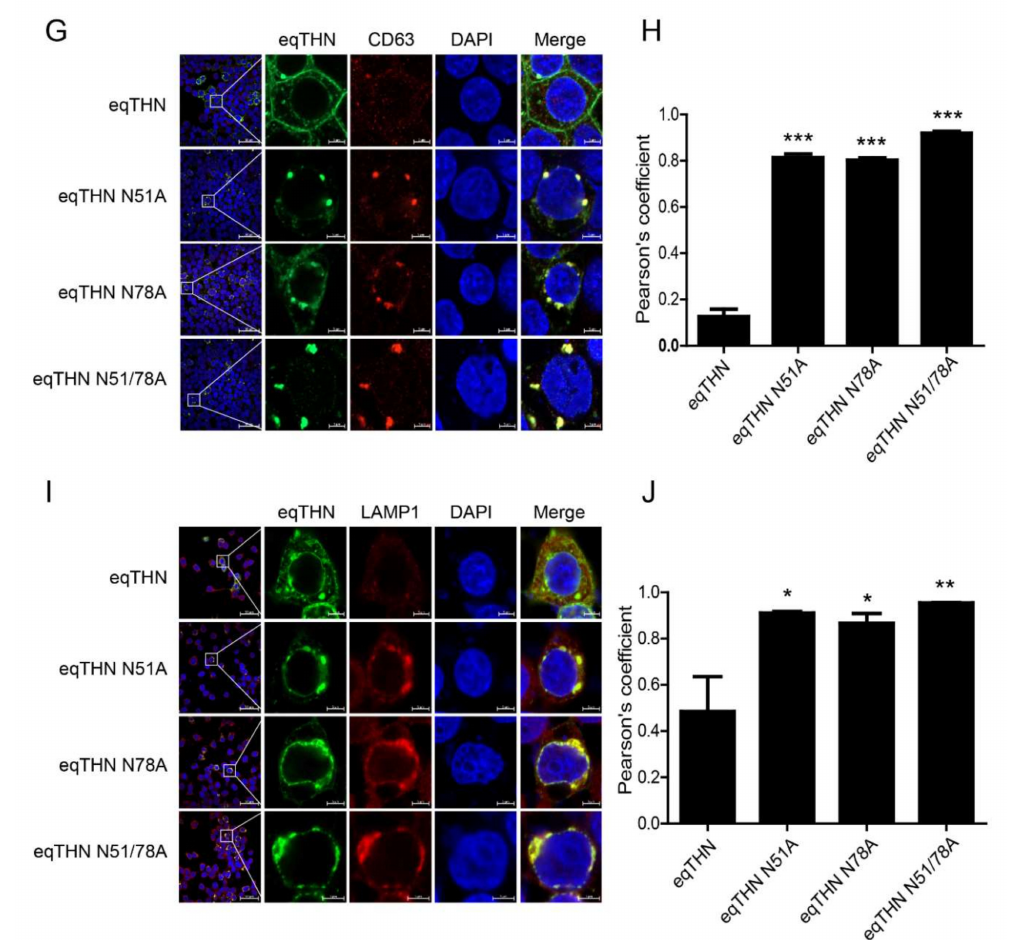
Figure 4. N-glycosylation modification mediates the normal tra ffi cking of eqTHN in cells. HEK293T cells transfected with 1 µ g of plasmids expressing eqTHN or its N-glycosylation mutants were investigated using confocal microscopy: blue, cell nucleus; green, eqTHN protein tagged with FLAG; red, KDEL for the endoplasmic reticulum ( A ), Rab 5 for early endosomes ( C ), Rab 7 for late endosomes ( E ) and cd63 and LAMP1 for lysosomes ( G , I ). Pearson correlation coe ffi cient values for the colocalization of eqTHN and ER ( B ), early endosomes ( D ), late endosomes ( F ) and lysosomes ( H , J ). Error bars from three independent experiments. ***, p < 0.001; **, p < 0.01; *, p < 0.05; ns, not